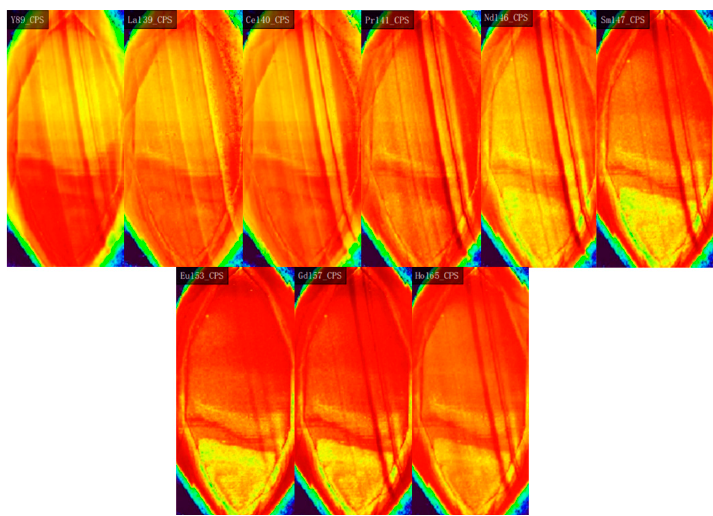
Figure 9. REE image in scheelite sample BWK2, obtained by